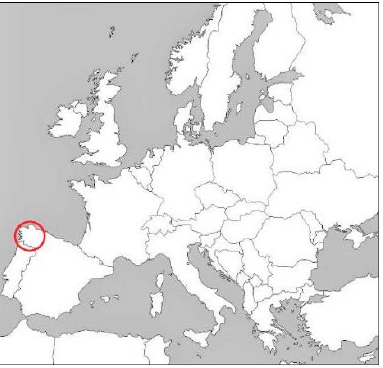
Figure 1. Situation of Gailica (Red). Own elaboration.